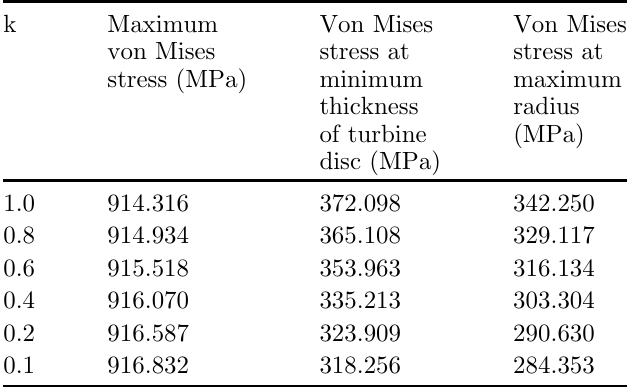
Table 16. Logarithmic fatigue lives of turbine disc for different k